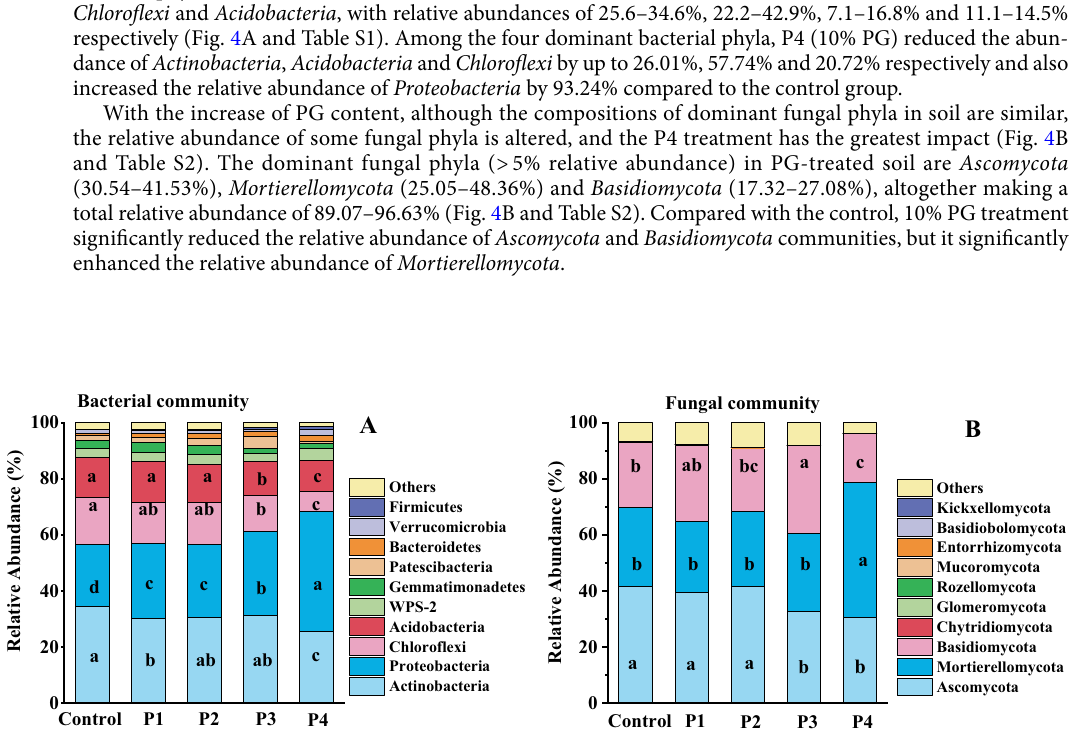
Figure 4. Effect of PG on the relative abundance of bacterial ( A ) and fungal ( B ) communities at the phylum level. Different lowercase letters represent significant differences at the level of P <